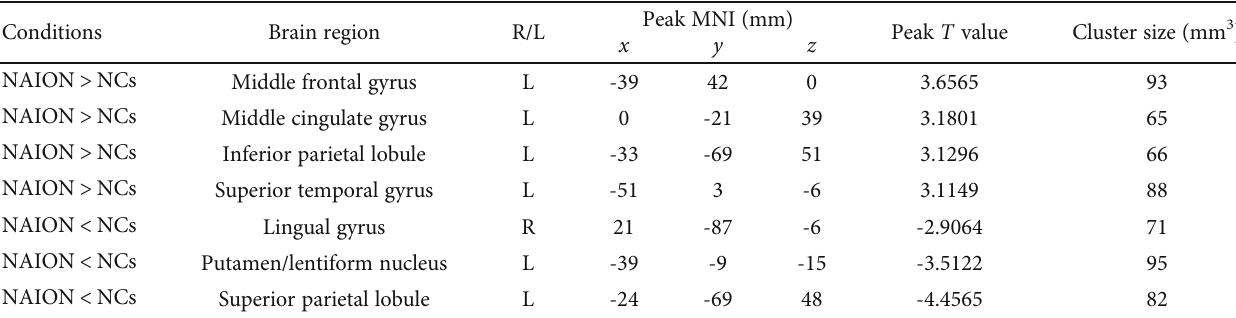
Table 2: ReHo values for patients with NAION and healthy